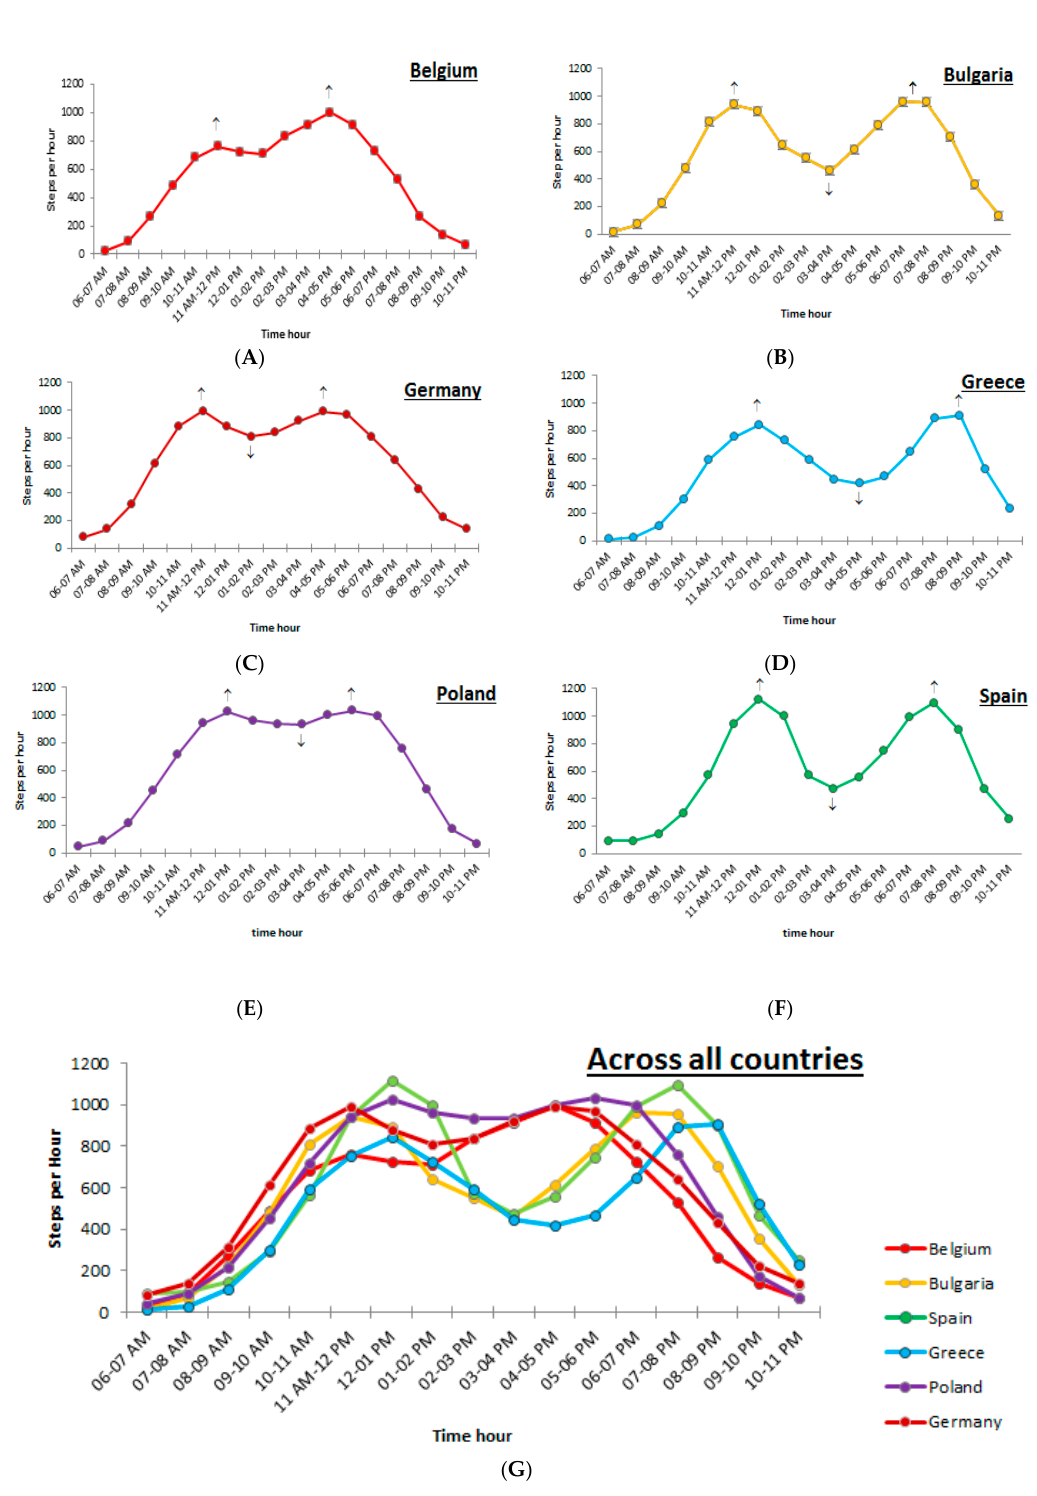
Figure 2. ( A ) Preschoolers’ step count patterns during weekend days in Belgium; ( B ) preschoolers’